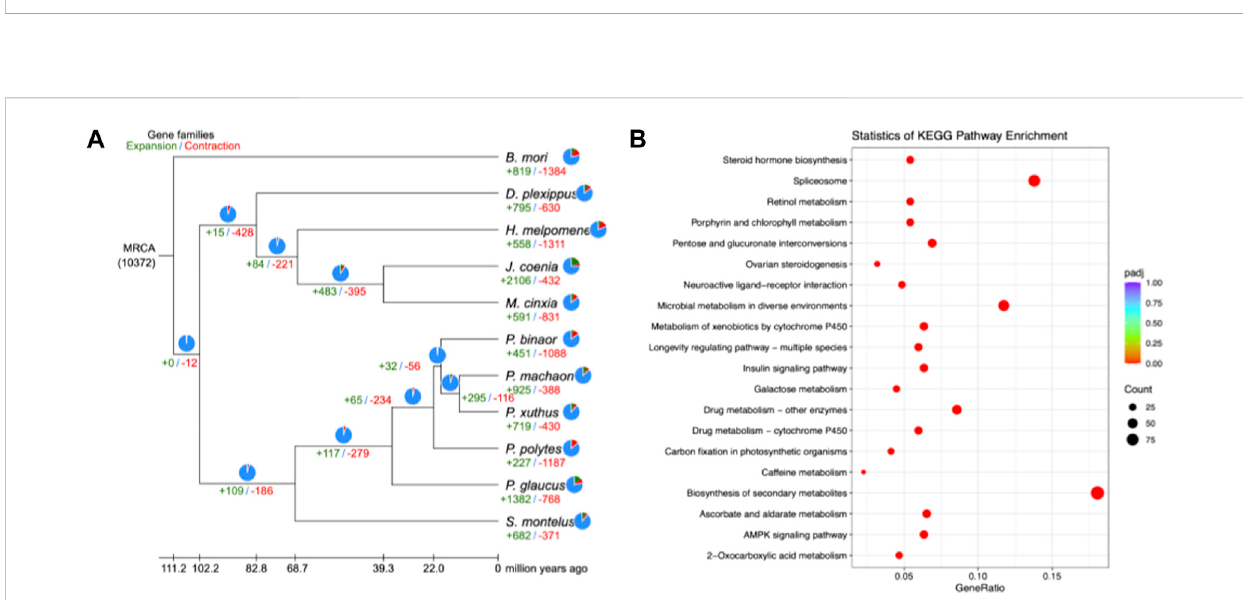
FIGURE 4 Gene family dynamics in S. montelus and relative species. (A) Expansions and contractions of gene families residing in S. montelus and its relatives. Thegreencolorrepresentsexpansion gene familiesand numbers. Thered colorrepresentscontraction genefamilies andnumbers. (B) Top20pathways with members of gene families enriched in S.